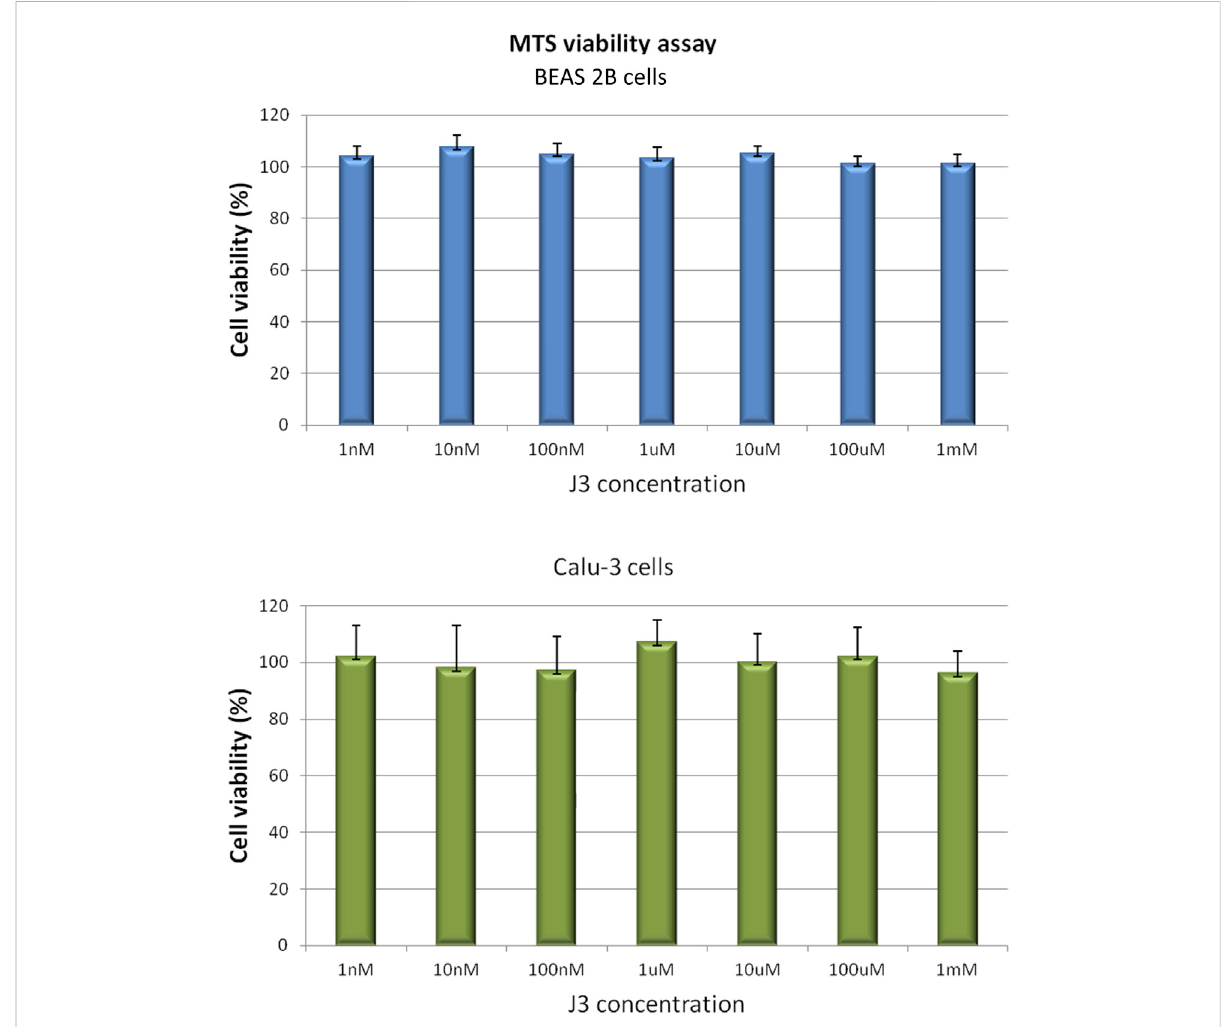
FIGURE 4 BEAS 2B and Calu-3 cells grown in a 96-multiwell plates were exposed for 72 h to J3 peptide applied at various concentrations ranging from 1 nM to 1 mM. Cell viability was determined by MTS assay. Values are represented as mean ± SD of three independent